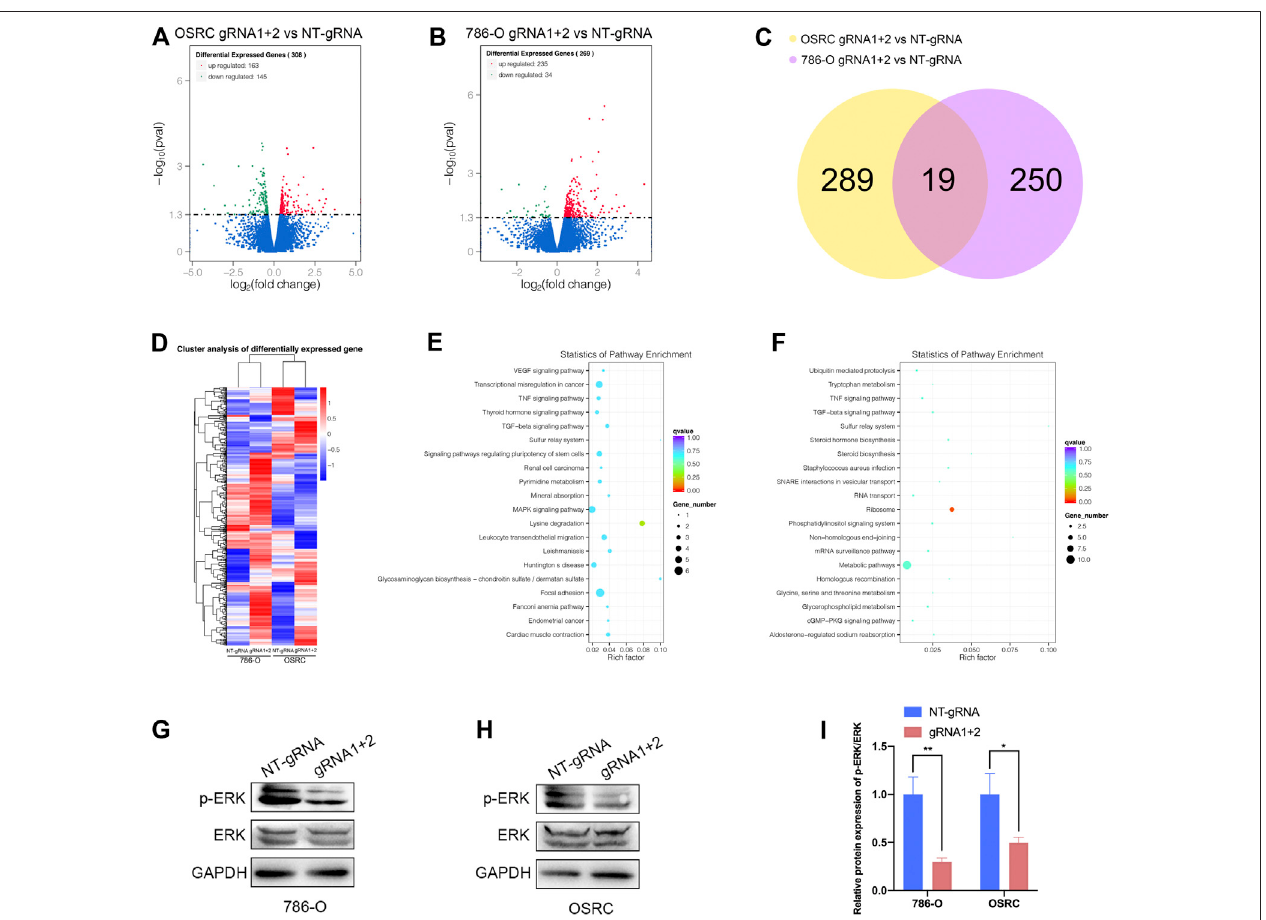
FIGURE 7 | Targeted demethylation of PLOD2 mRNA regulates downstream target genes expression. (A,B) The scatter diagram showed the differentially expressedgenes(DEGs)inPLOD2demethylated786-OandOSRCcells. (C) ThevenndiagramsummarizedtheoverlapofPLOD2regulatedgenesinbothcells. (D) The heatmapshowedthedifferentiallyexpressedgenes(DEGs)inPLOD2demethylated786-OandOSRCcells. (E,F) KEGGpathwayanalysisofDEGsin786-OandOSRC cells. (G – I) The protein levels of MAPK pathway related proteins were measured in PLOD2 demethylated 786-O and OSRC cells by western